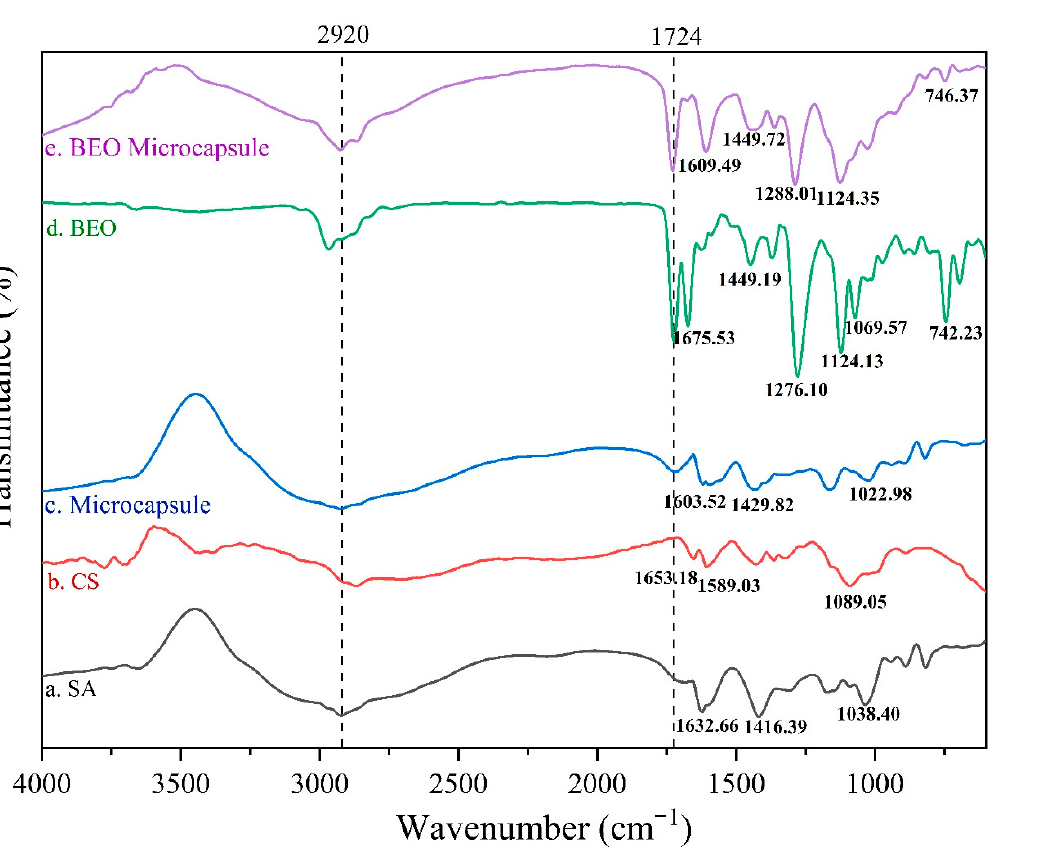
Figure 3. FTIR spectrums of different wall materials, BEO and microcapsules.